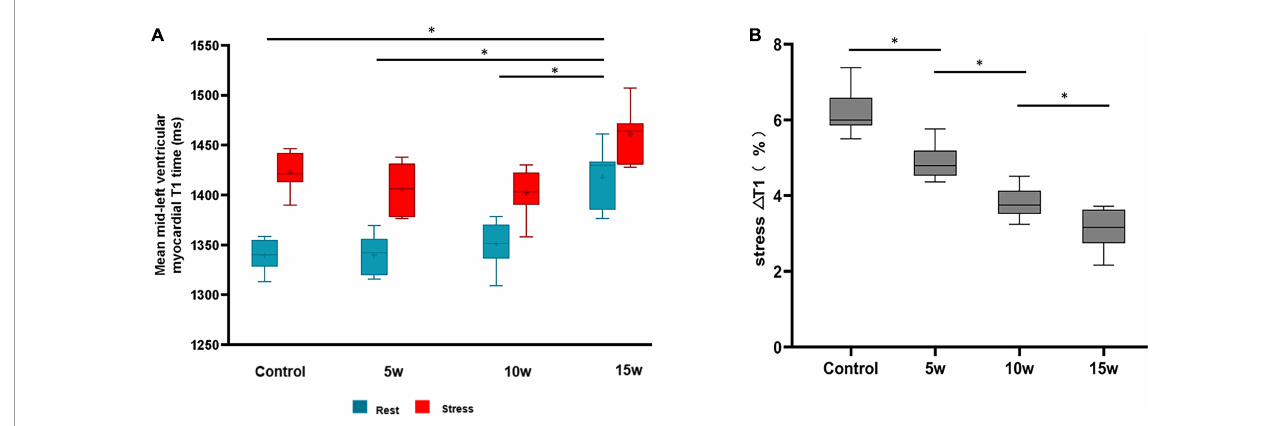
FIGURE5 Differences at rest vs. stress of LV myocardial T1 values between healthy controls and rabbits with T2DM (A) . The myocardial T1 responses to ATP stress (stress (cid:49) T1) (B) . The data are expressed as the means ± SD. LV, left ventricular; T2DM, type 2 diabetes mellitus.